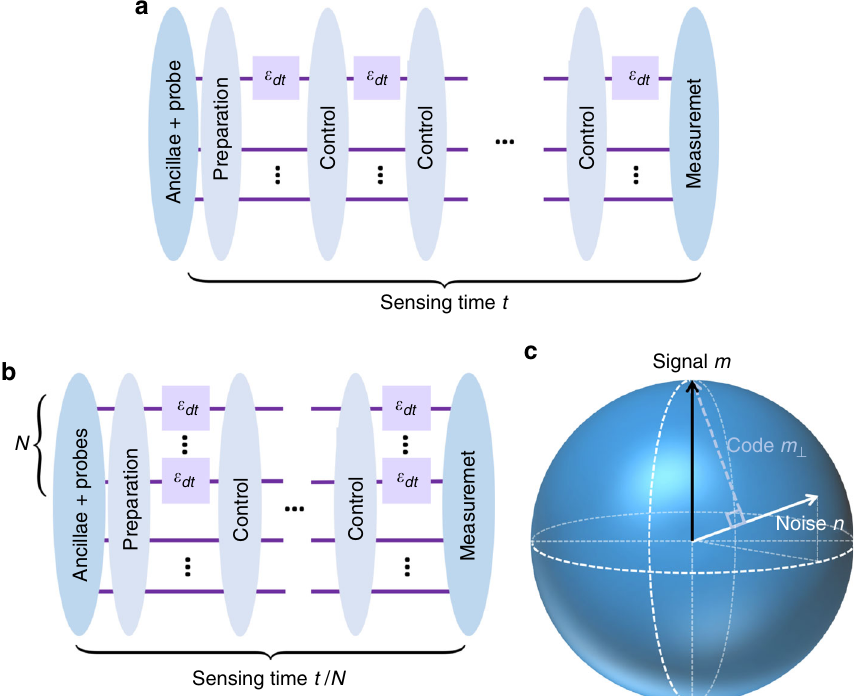
Fig. 1 Metrology schemes and qubit probe. a The sequential scheme. One probe sequentially senses the parameter for time t , with quantum controls applied every dt . b The parallel scheme. N probes sense the parameter for time t / N in parallel. The parallel scheme can be simulated by the sequential scheme. c The relation between the signal Hamiltonian, the noise, and the QEC code on the Bloch sphere for a qubit